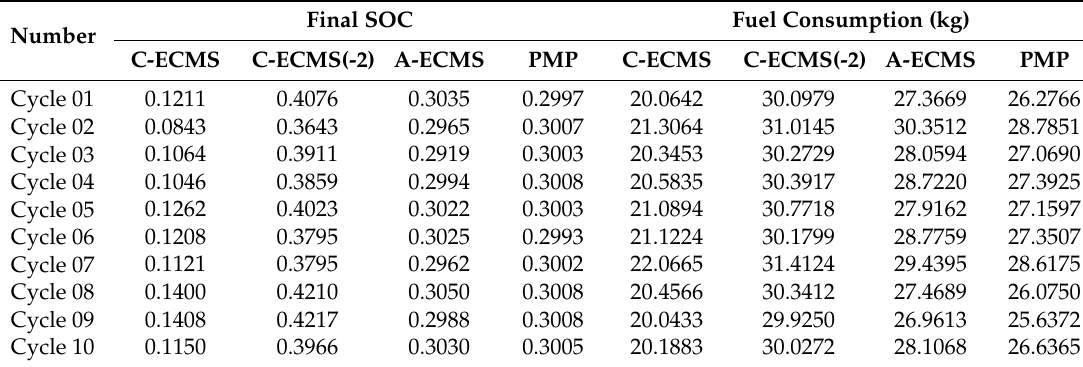
Table 6. Comparison statistics with initial SOC = 0.95.